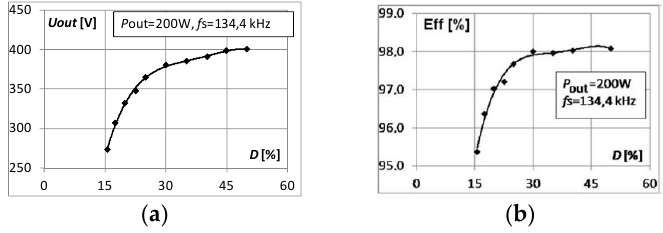
Figure 17. ( a ) Output voltage U out of SCVD and ( b ) its e ffi ciency in DCM mode as a function of duty cycle D = T 1 / T S . U in = 200 V, f s = 134.4 kHz, P out = 200 W, t M = 50 ns. Switching pattern